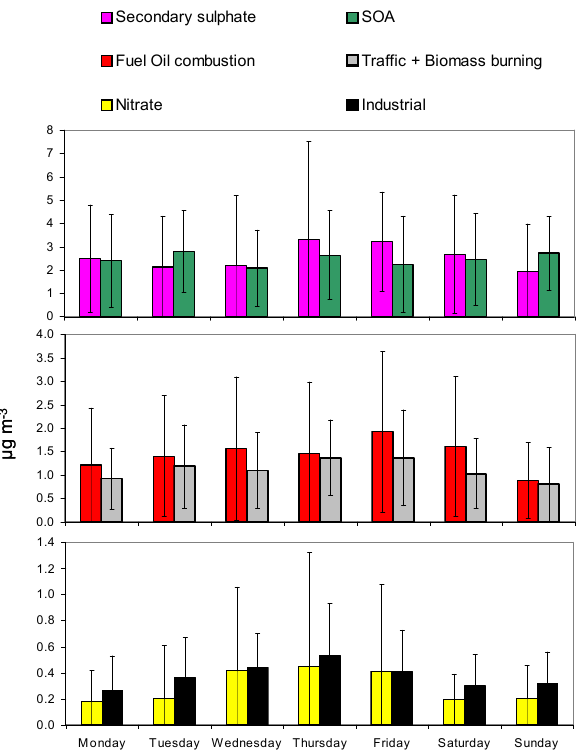
Fig. 5. Average daily concentrations (µgm − 3 ) of each source.